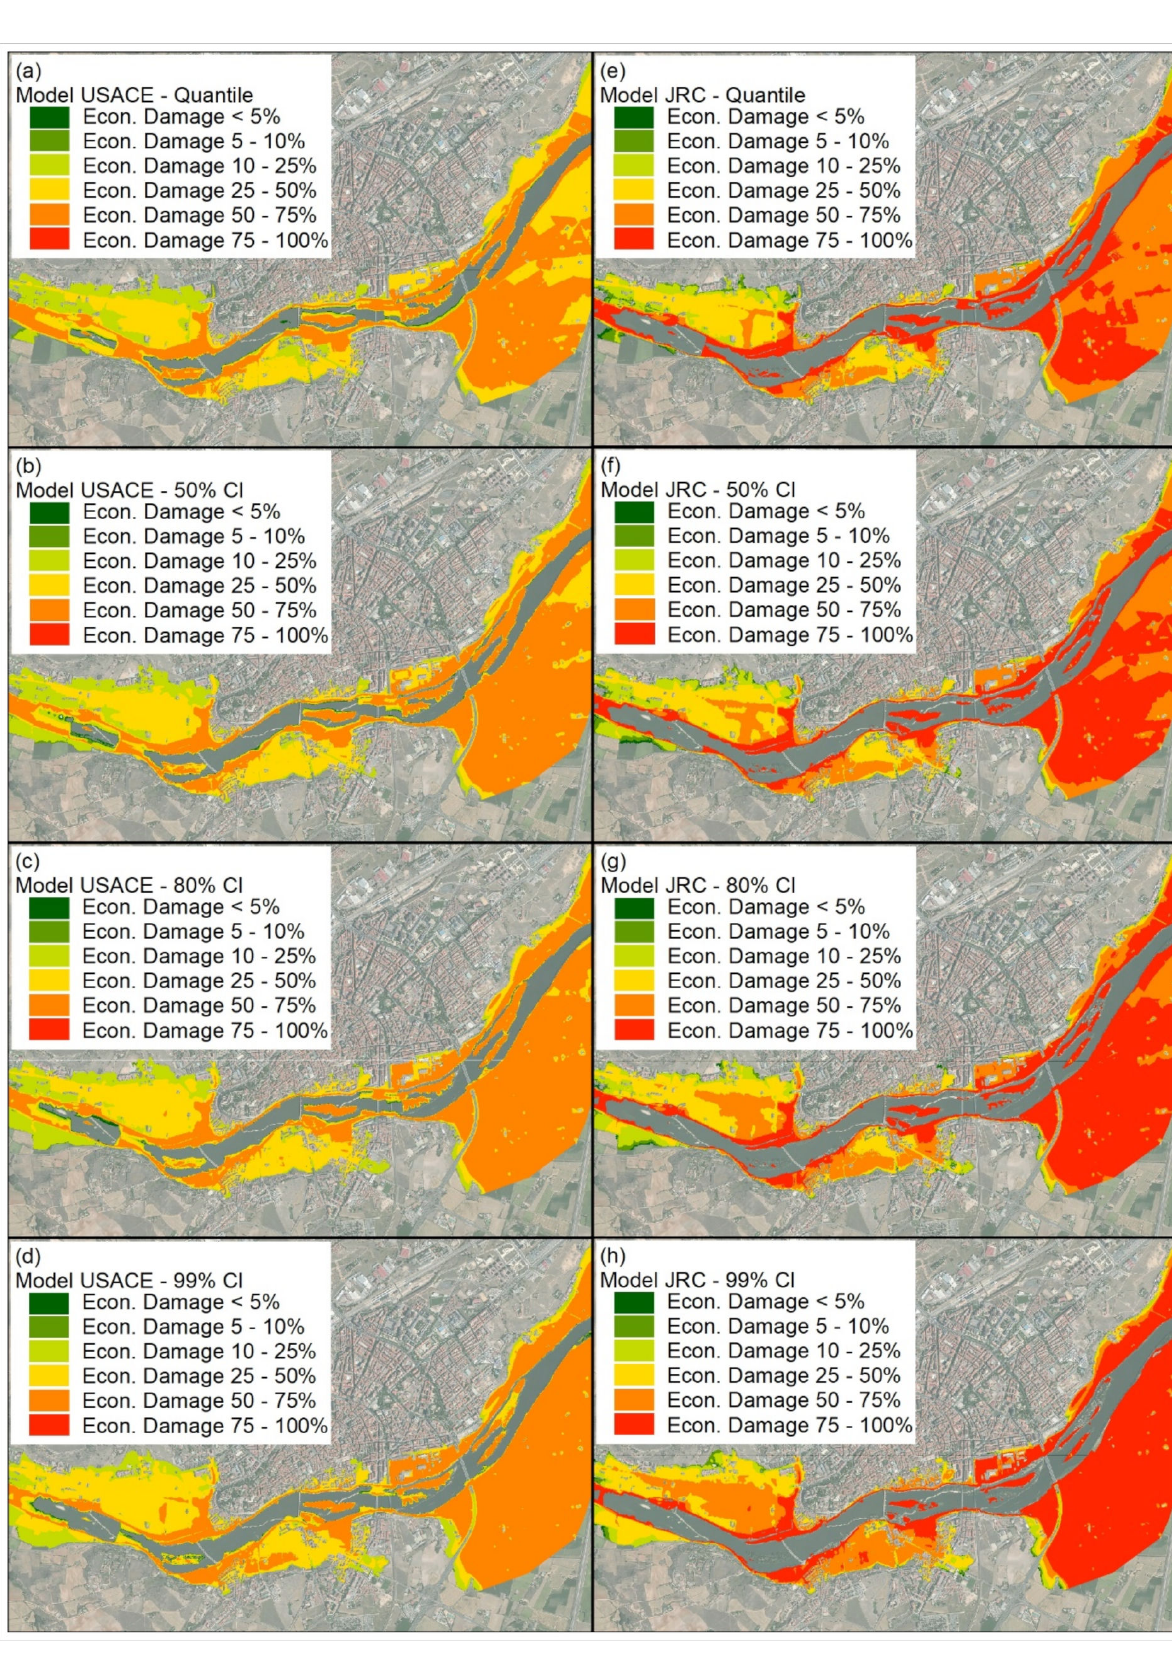
Figure 6. Probabilistic map of building economic damage (%) areas in Zamora city (Spain) for the USACE [44] model ( a – d ), and the JRC-Huizinga et al. [45] model ( e – h